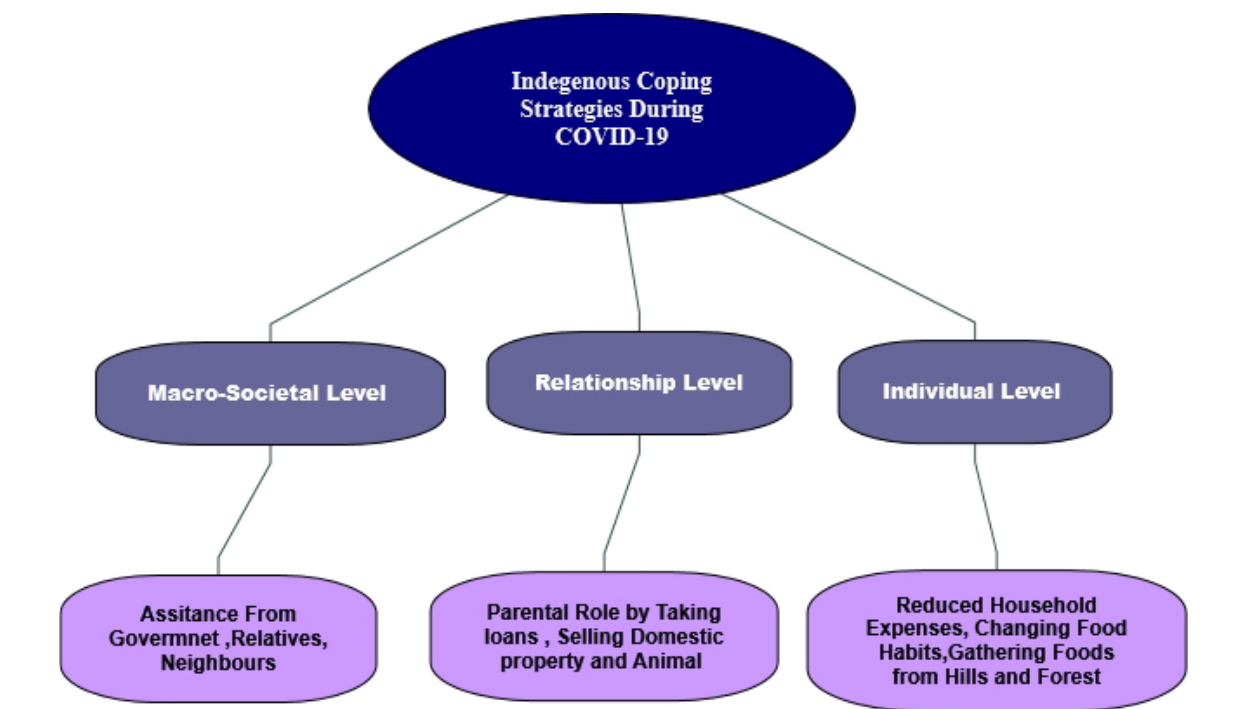
Figure 1. Indigenous household coping strategies through Huston’s social–ecological theory.